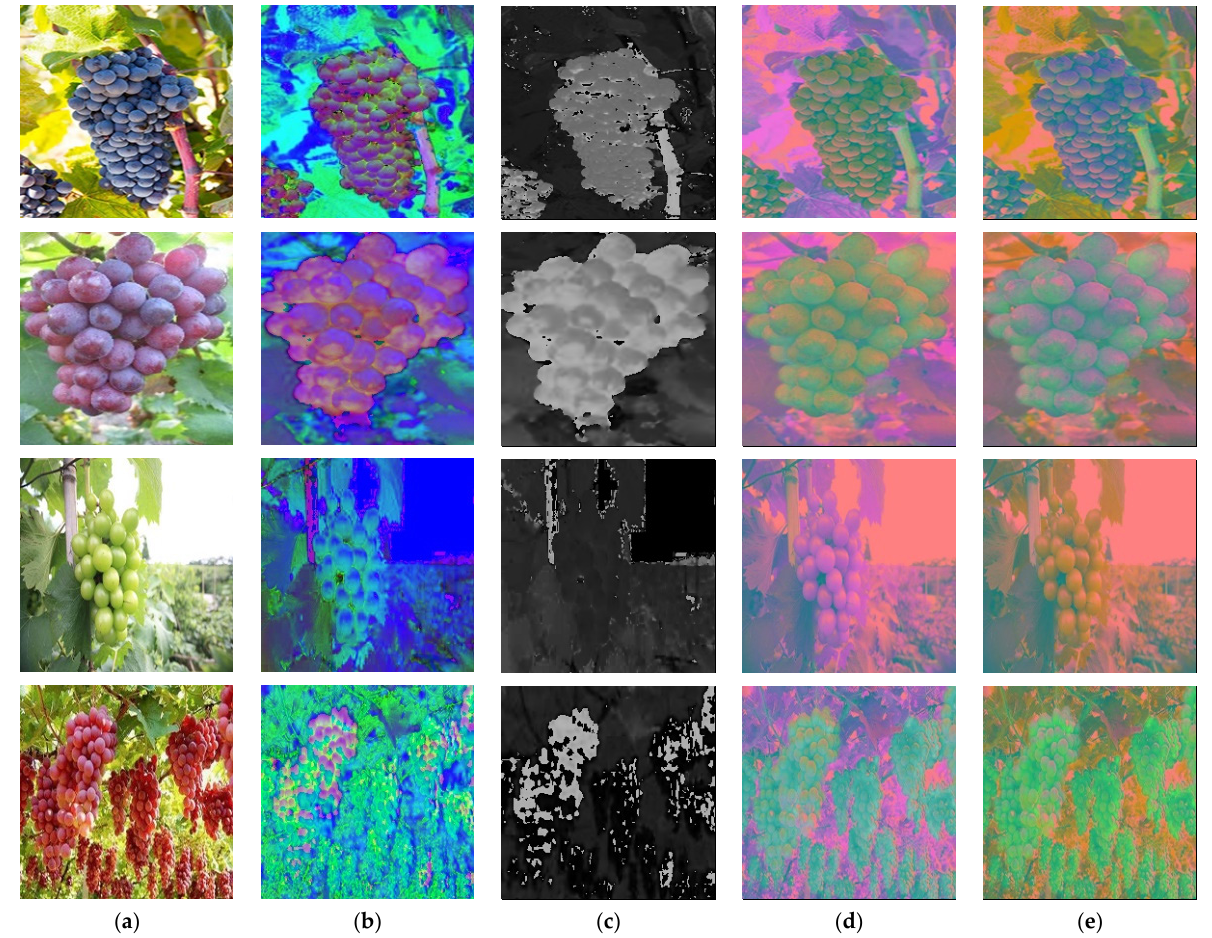
Figure 5. Grapes of different varieties with different input representations, column ( a – e ) are RGB, HSV, HHH, L*a*b*, and YCrCb, respectively.